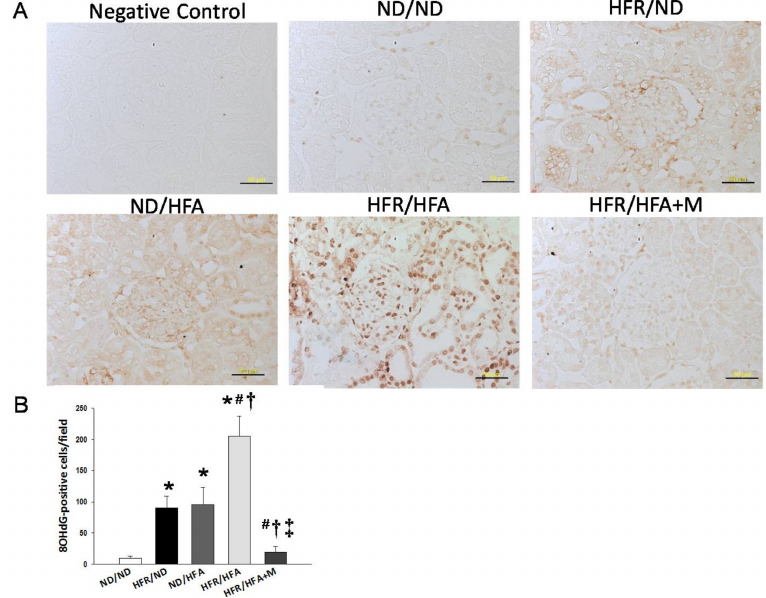
Figure 4. ( A ) Light microscopic findings of 8-hydroxydeoxyguanosine (8-OHdG) immunostaining in the kidney cortex in 12-week-old male offspring. Bar = 50 µ m; ( B ) Quantitative analysis of 8-OHdG-positive cells per microscopic field (400 × ); * p < 0.05 vs. ND/ND, # p < 0.05 vs. HFR/ND, † p < 0.05 vs. ND/HFA, ‡ p < 0.05 vs.